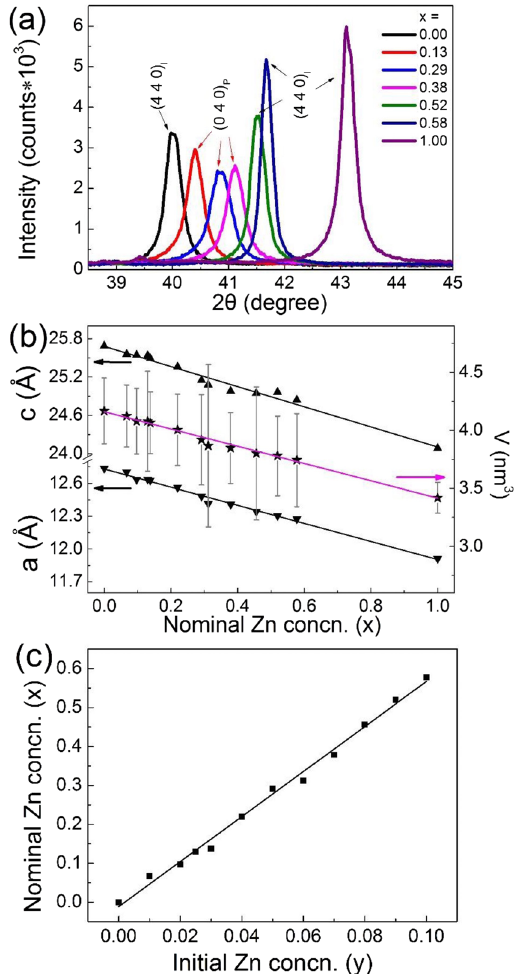
Figure 3. Panel (a): The (440) I peaks and the counterpart (040) P peaks in the powder XRD patterns for (Cd 1 − x Zn x ) 3 As 2 . Panel (b): The lattice constants and the volume of the primitive cell change with the concentration (concn.) of zinc x linearly. Panel (c): The nominal concentration of zinc x and the initial y have a linear dependence for 0.00 ≤ x <